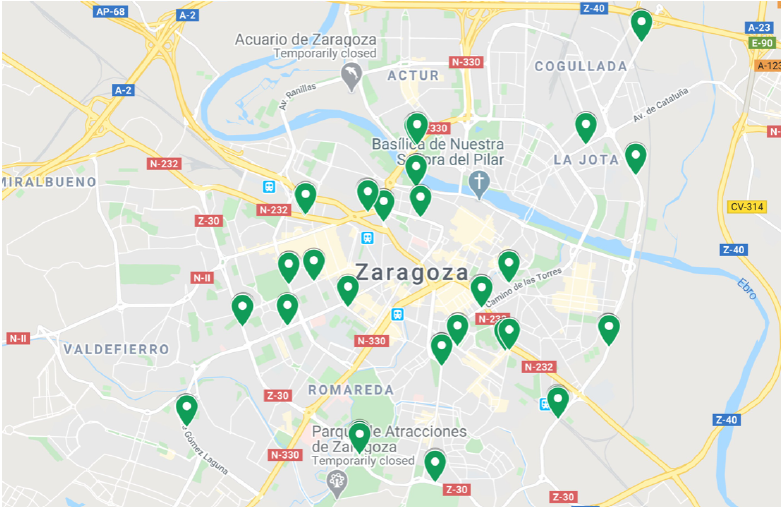
Figure 2. Static traffic sensors in Zaragoza (shown with green markers). Map data: Google, Instituto Geográfico Nacional,